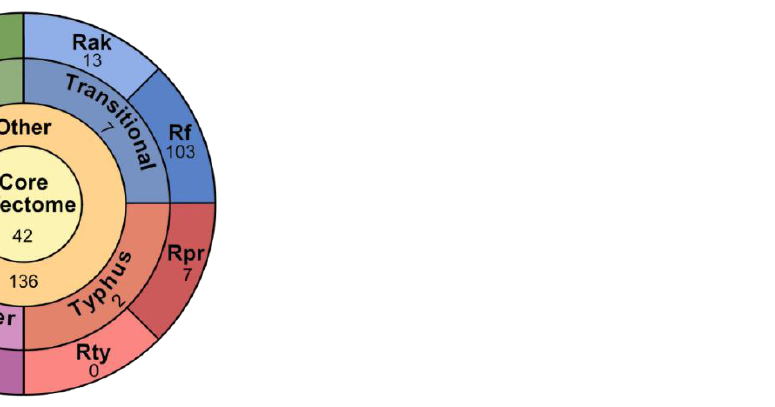
Figure 4. Categorization of 580 chromosomal EHSs. Each section contains a number corresponding to the number of EHSs found in the category. The center circle labeled “core effectome” represents all chromosomal EHSs conserved in all analyzed species of Rickettsia . The “other” ring represents the EHSs that are not core, but also not specific to a single group or species. The “group” ring is split into four segments, representing the four groups of Rickettsia analyzed in this study. Finally, the “species” ring is split into eight segments, representing each species used in this study. The 2–3 letter labels correspond to the species name with Rb standing in for R. bellii str. RML396-C, Rsp for R. sp. MEAM1, Rf for R. felis str. URRWXCal2, Rak for R. akari str. Hartford, Rr for R. rickettsia str. Sheila Smith, Rmt for R. montanensis str. OSU 85-930, Rpr for R. prowazekii str. Breinl, and Rt for R. typhi str. Wilmington.